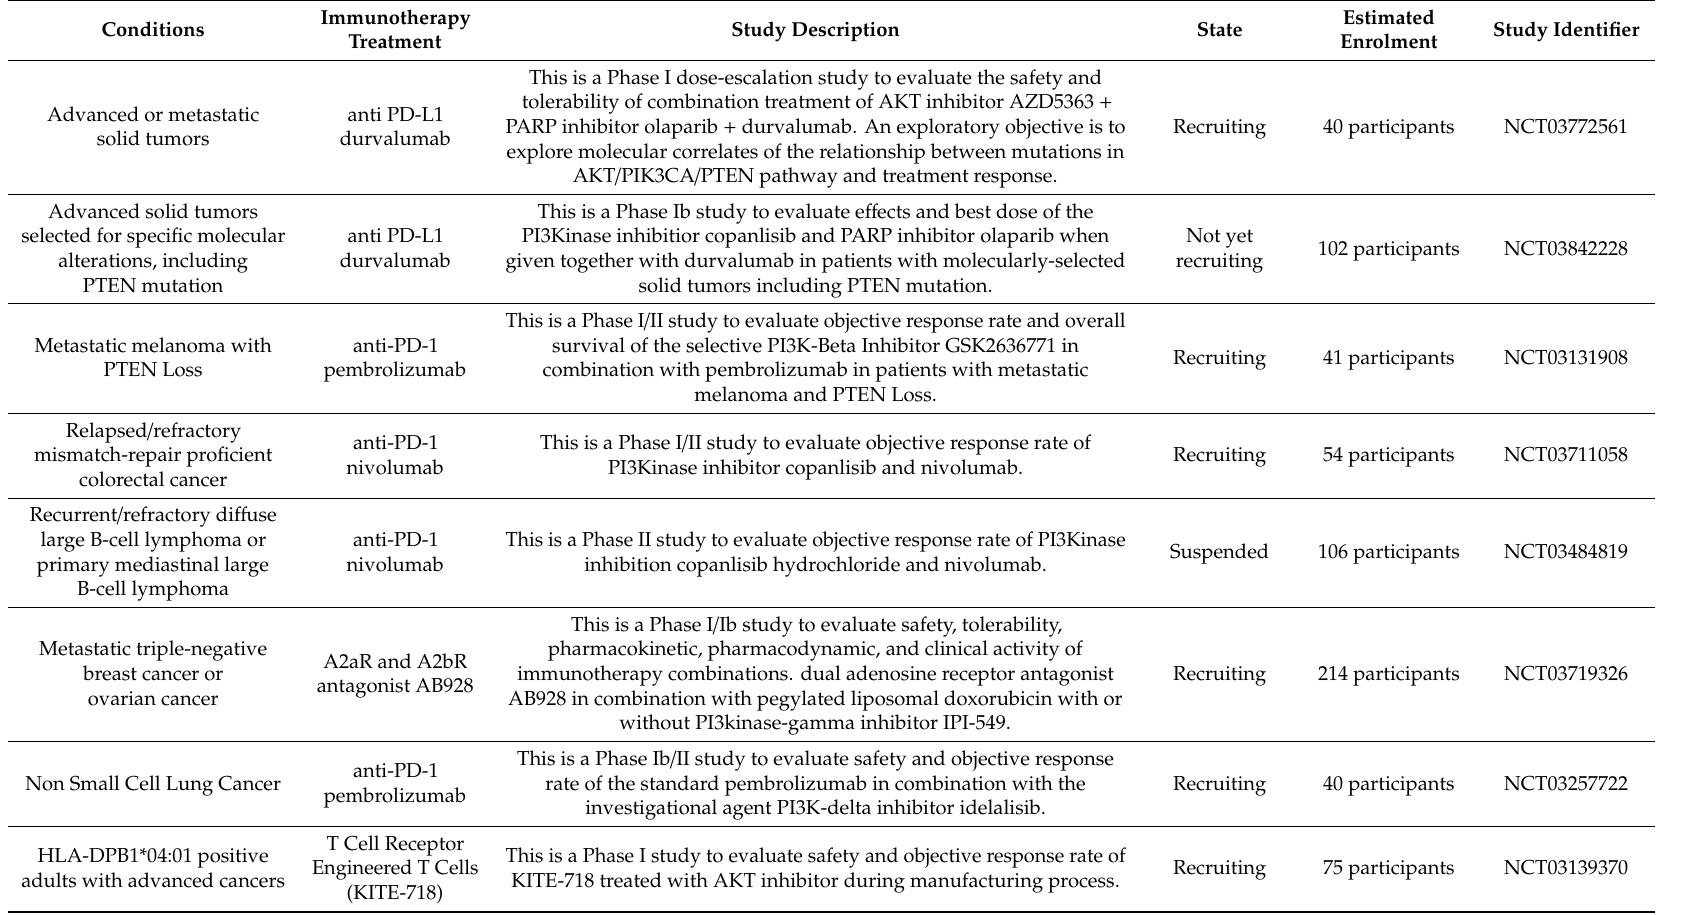
Table 3. Current clinical trials investigating PTEN-PI3K-AKT pathway and